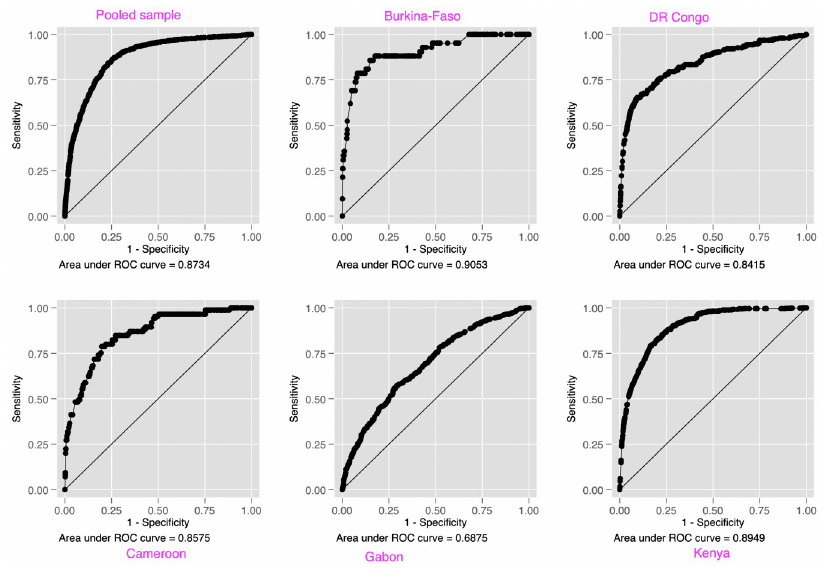
Fig 3. Receiver operating curves.